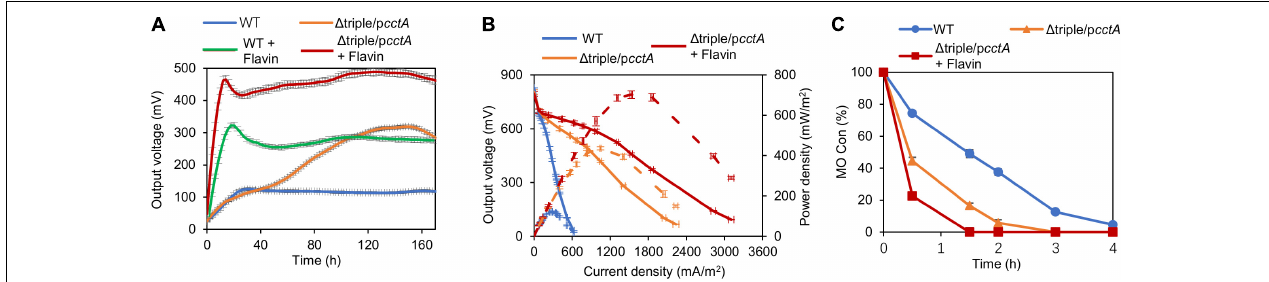
FIGURE 7 | Impacts of riboflavin (RF) on MFC performance of the optimized strain. (A) Output voltage of MFCs incubated with the (cid:49) triple/p cctA and WT, across the 2,000- (cid:127) external resistor without or with the addition of RF. (B) Polarization curves and power density curves (dashed lines) determined by measuring the stable output voltage generated across various external resistances. (C) MO kinetic traces of the (cid:49) triple/p cctA without or with addition of RF. Three independent operations were performed, and data are presented by the means ± SD. In all panels, the differences in the peak values between the strains under test without or with addition of RF were <